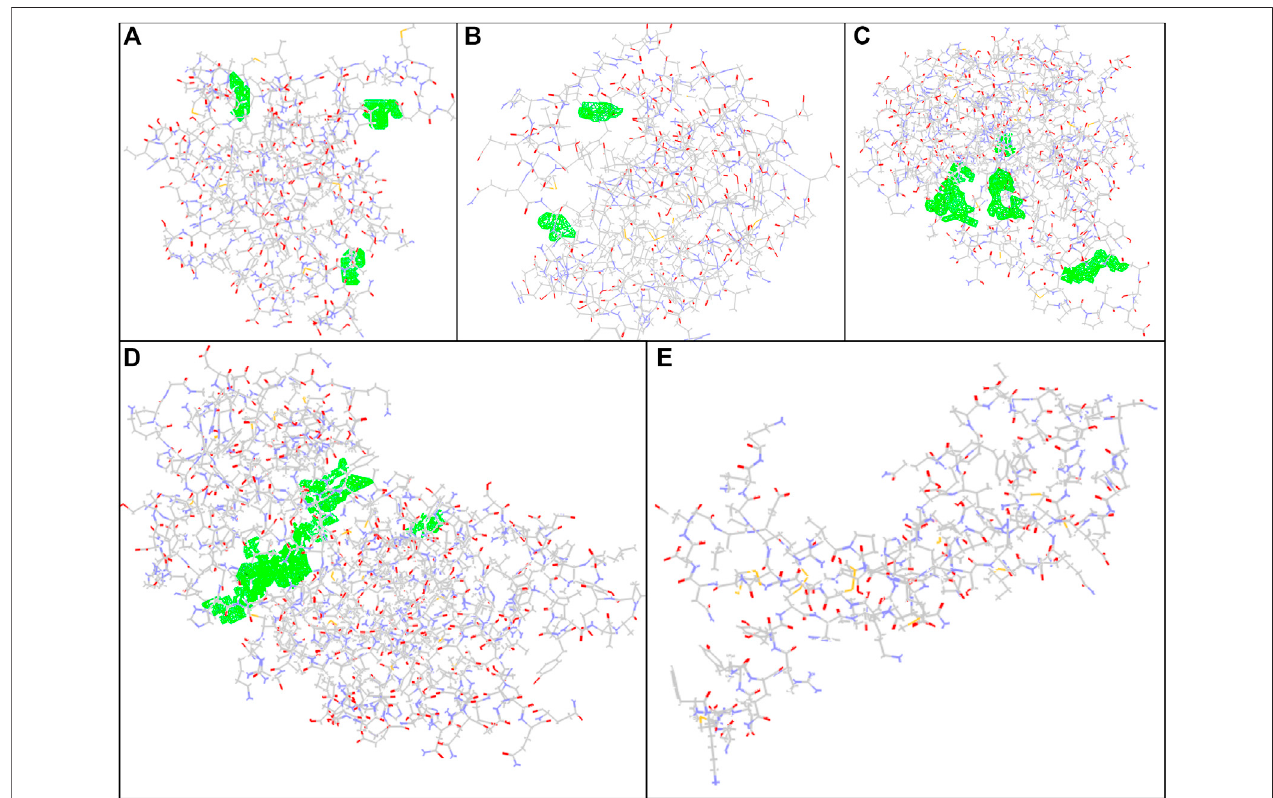
FIGURE 1 | Docking conformation and active sites. (A) Bax, (B) Bcl-2, (C) Caspase-8, (D) KDR1, and (E) VEGF-A target proteins (PDB, ID, 5W5X, 5JSN, 1I4E, 2QU5, and 5t89, respectively) using MVD studies. Detected cavities; green; carbon atom; grey; oxygen atoms; red; nitrogen atoms;